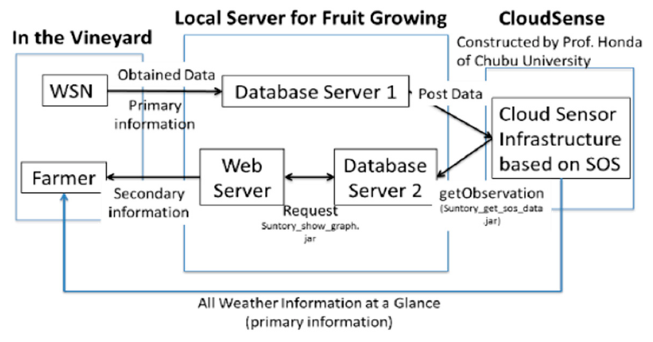
Figure 10. Design of agricultural IoT as a service for farmers